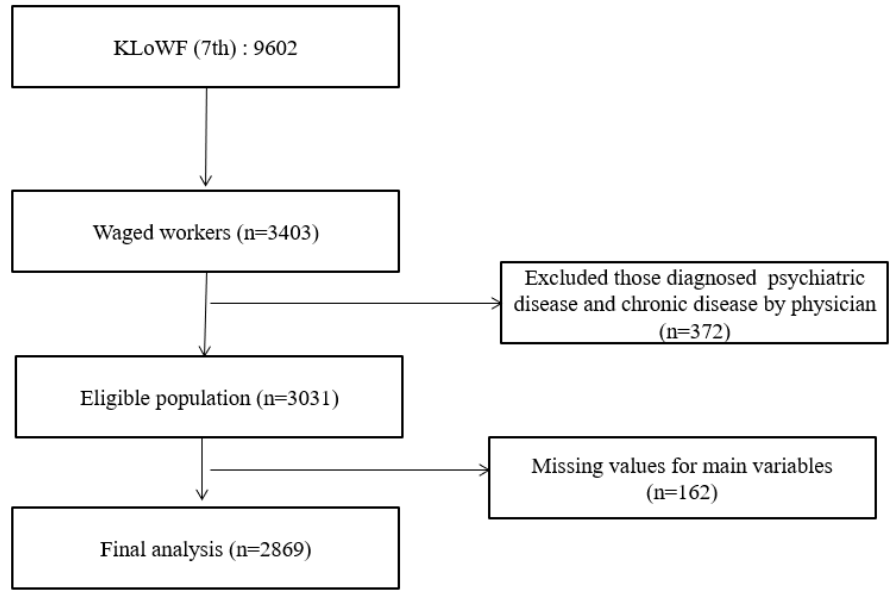
Figure 1. Flow diagram of inclusion and exclusion of participants. Note. KLoWF, Korean Longitudinal Survey of Women and Families.